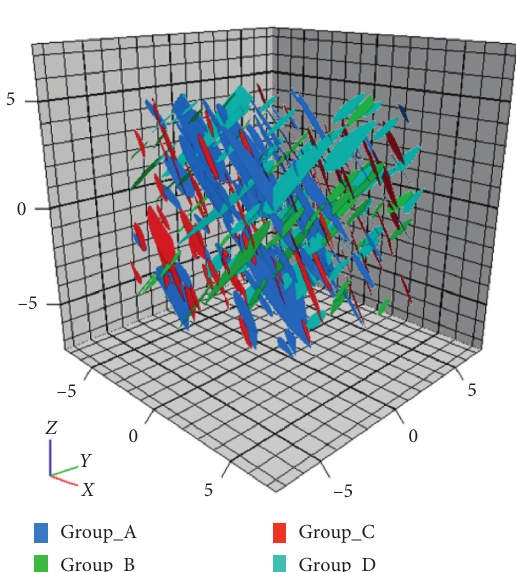
Figure 6: Stochastic joint network